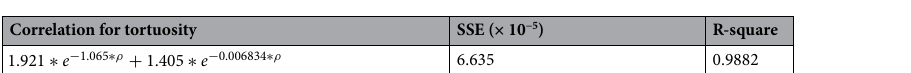
Correlation for